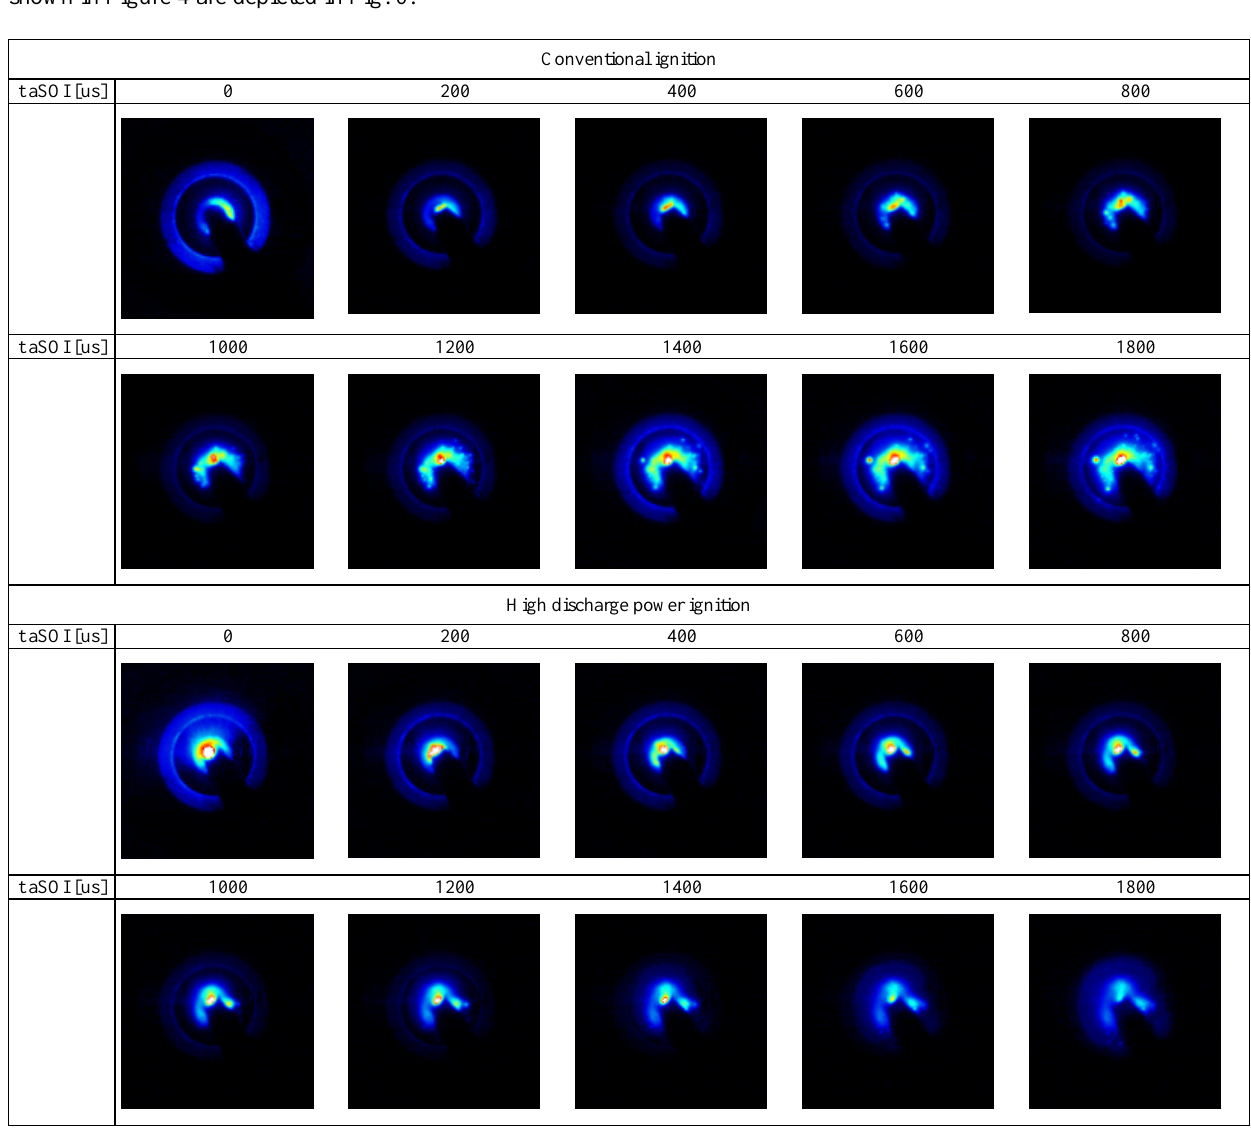
Fig. 4. Optical analysis algorithm using DaVis 7.2